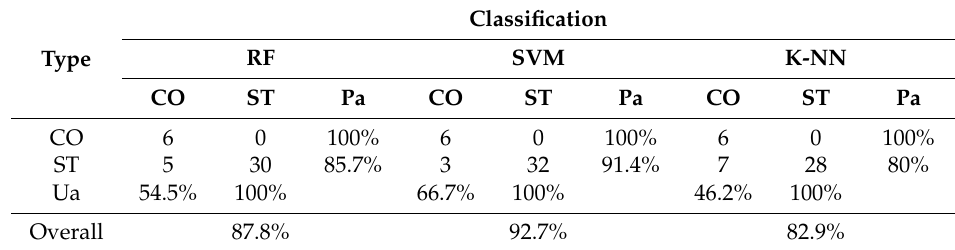
Table 7. Classification results of Image 3 using different methods (CO = totally collapsed building, ST = standing building; Pa = producer’s accuracy, Ua = user’s